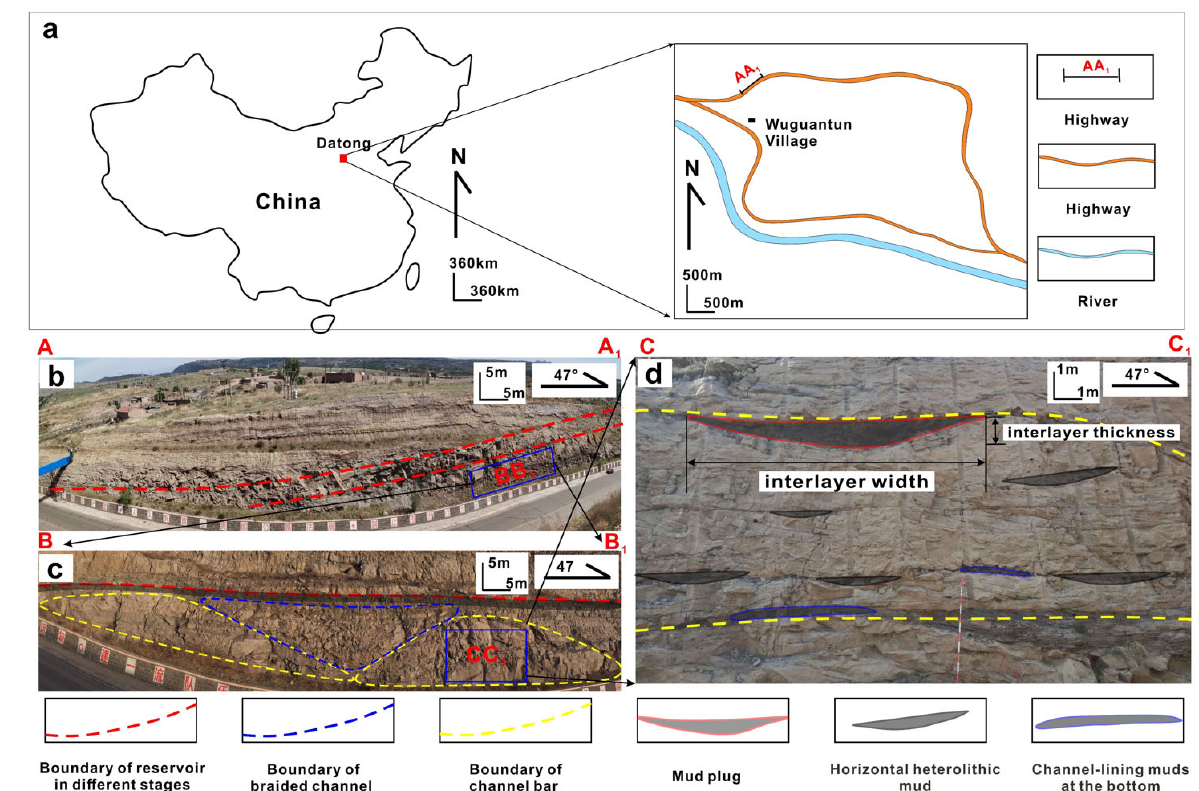
Figure 3. The measurement method of paleo-outcrop. ( a ) Location of sedimentary paleo-outcrops. ( b ) Braided river sandbodies in different sedimentary periods. ( c ) Single-stage braided river sandbodies paleo-outcrops. ( d ) Measurement of internal interlayer parameters in single sand body.